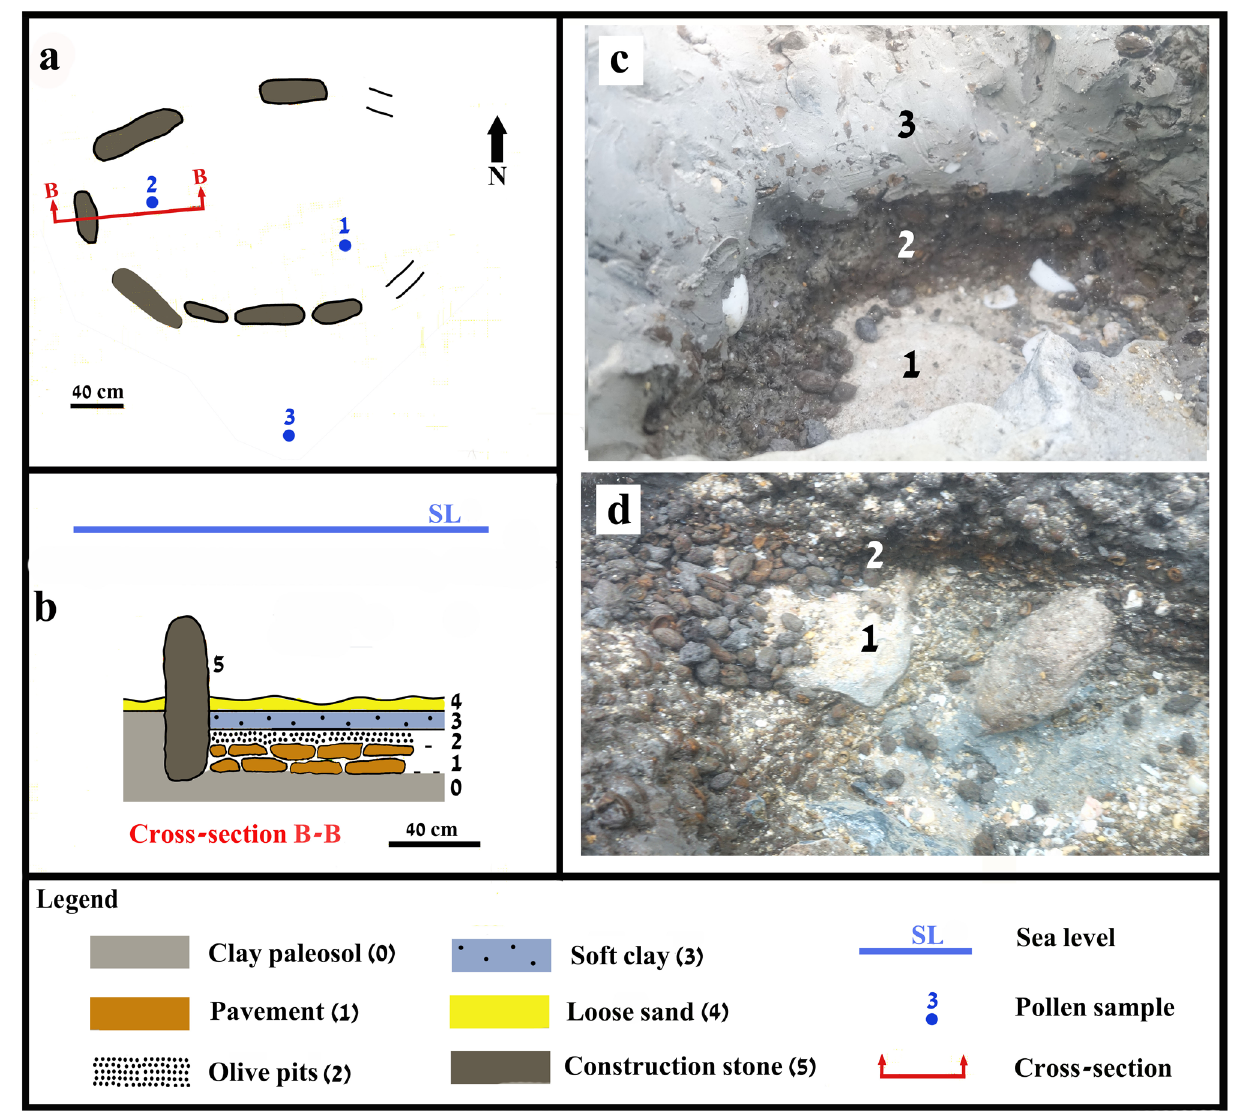
Figure 4. ( a ) Plan of Structure B; ( b ) Enlarged cross-section of Structure B and its layers (0–4); ( c ) Pavement (marked as 1) overlain by olive pits (marked as 2) overlain by grey, soft clay (marked as 3); ( d ) A close-up of the pavement (marked as 1) overlain by olive pits (marked as 2) (SL refers to the high tide during 13. 3. 2018, at 1.30 PM) (Photos and drawing Ehud